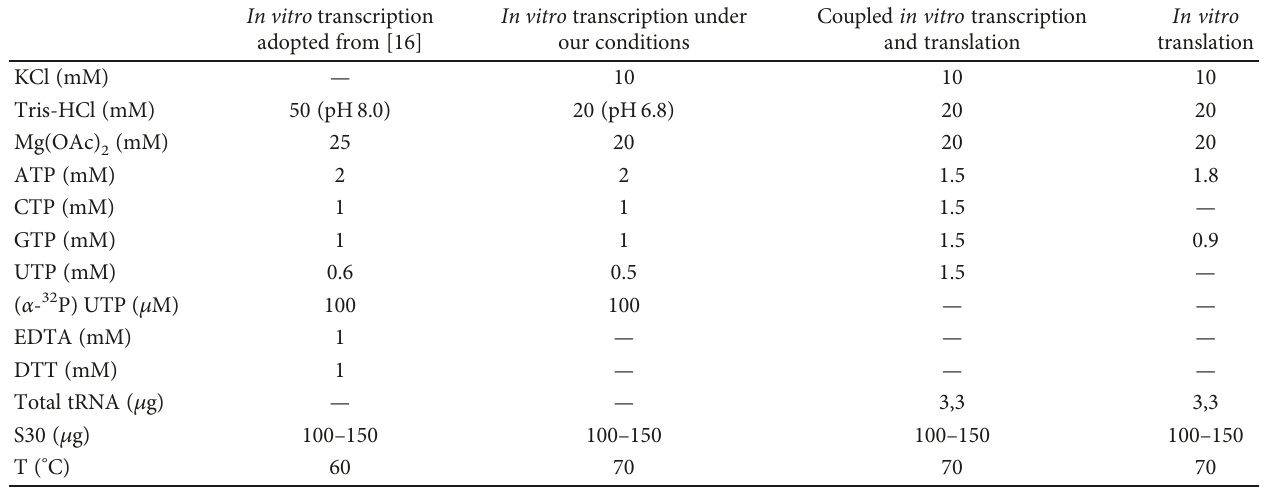
Table 1: Experimental conditions adopted for reactions with S30 S.